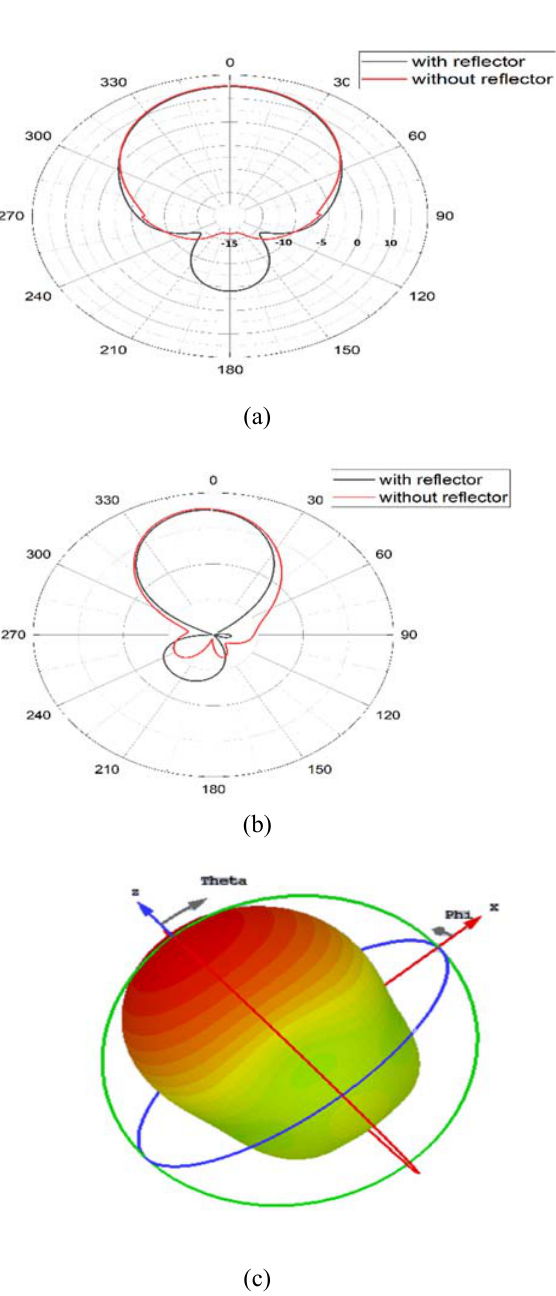
Fig 9. Reflection coefficient simulated with and without reflector elements.